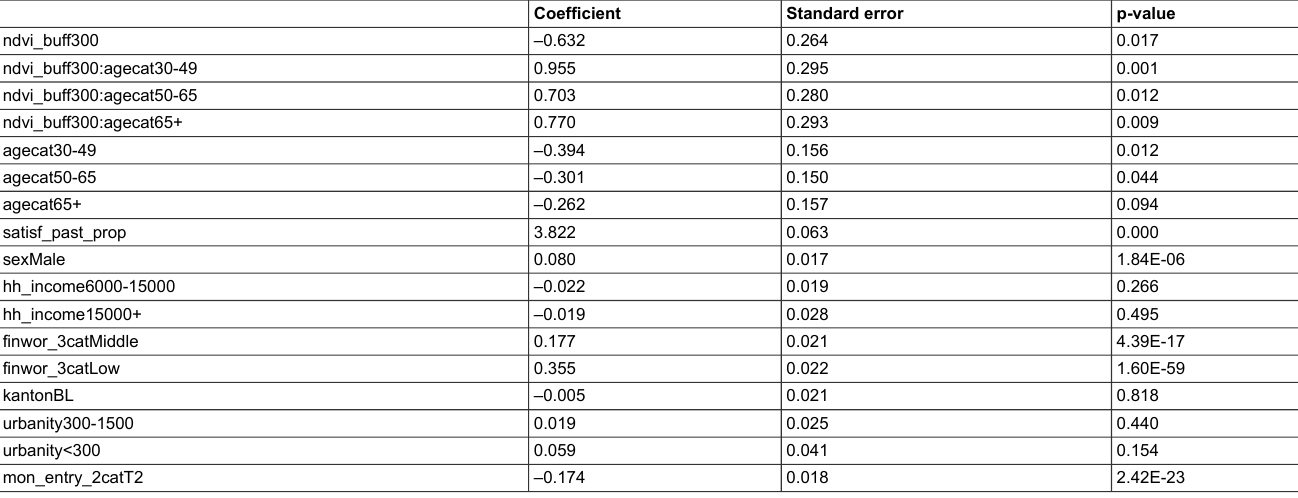
Table 2: Moderation by age categories (likelihood ratio test p-value = 0.016). Results from Beta regression of life satisfaction on NDVI by age categories, adjusted for life satisfaction in the past, sex, household income, financial worries, canton, degree of urbanisation, and month of